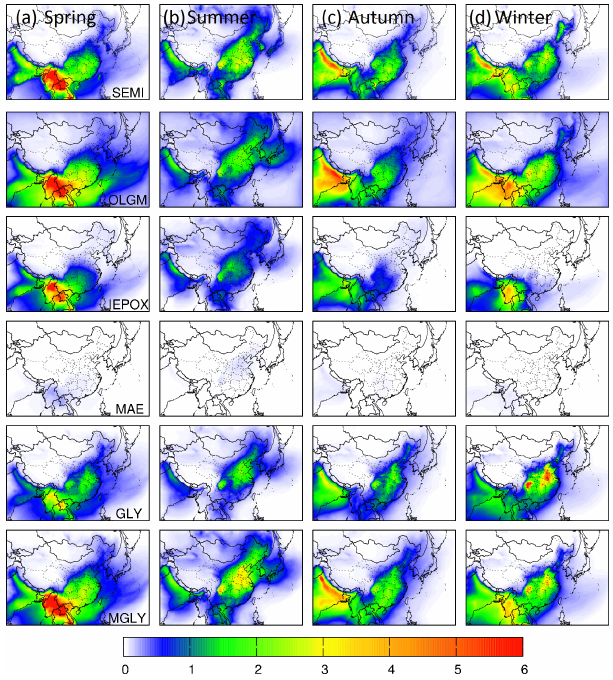
Figure 5. Predicted seasonal average SOA component concentra- tions in (a) spring, (b) summer, (c) autumn and (d) winter 2011. Units are µgm − 3 . SEMI: semivolatile SOA; OLGM: oligomers; IEPOX: SOA from isoprene epoxide; MAE: SOA from methacrylic acid epoxide; GLY: SOA from glyoxal; MGLY: SOA from methyl- glyoxal.